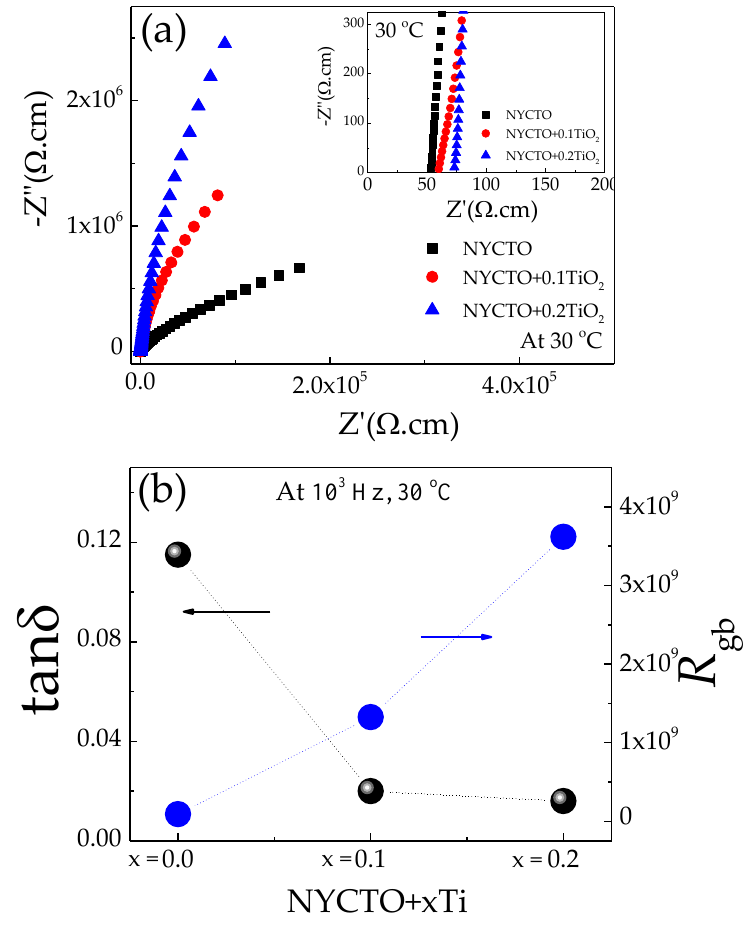
Figure 4. ( a ) Impedance complex plane (Z*) plots of NYCTO + xTiO 2 ceramics at 30 ◦ C; inset shows the enlarged view near the origin, showing a nonzero intercept. ( b ) Relationship of loss tangent (tan δ ) at 1 kHz and 30 ◦ C and grain boundary resistance ( R gb ) at 30 ◦